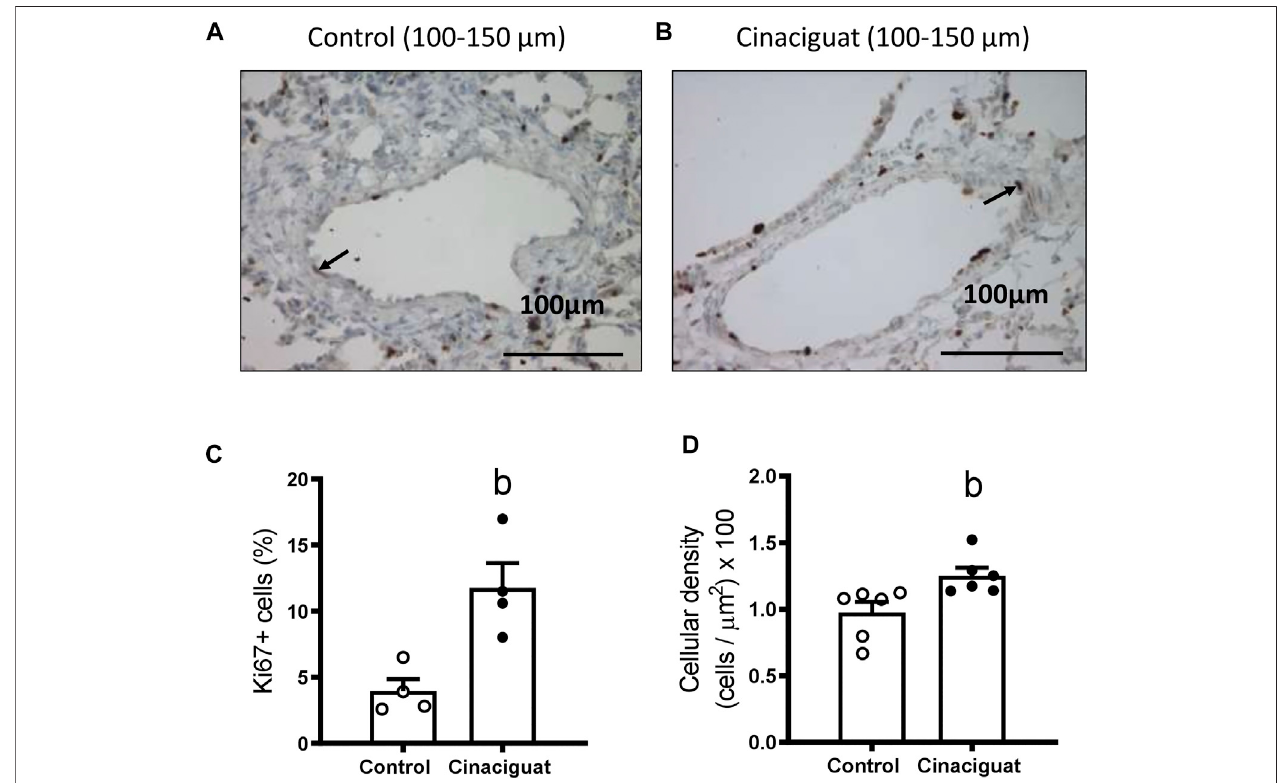
FIGURE 6| Effect ofCinaciguat treatment on muscle layer proliferation (Ki67 expression) and cellular density in smallpulmonary arteries of chronically hypoxicand pulmonary hypertensive neonatal lambs. Representative micrograph of small pulmonary arteries, between 100 and 150 μ m of luminal diameter, from Control (A) and Cinaciguat-treated lambs (B) . Ki67+ cells are shown with an arrow. Bar: 100 μ m. Magni fi cation: ×40. Percentage of Ki67+ cells of small pulmonary arteries (C) . Control (Open circles, n = 4) and Cinaciguat-treated lambs (Black circles, n = 4). Values are means ± SEM. Signi fi cant difference ( p ≤ 0.05): b vs. Control group. Cellular density in muscle layer (cells/µm 2 ) ×100 (D) . Control (Open circles, n = 6) and Cinaciguat-treated lambs (Black circles, n = 6). Values are means ± SEM. Signi fi cant difference ( p ≤ 0.05): b vs. Control